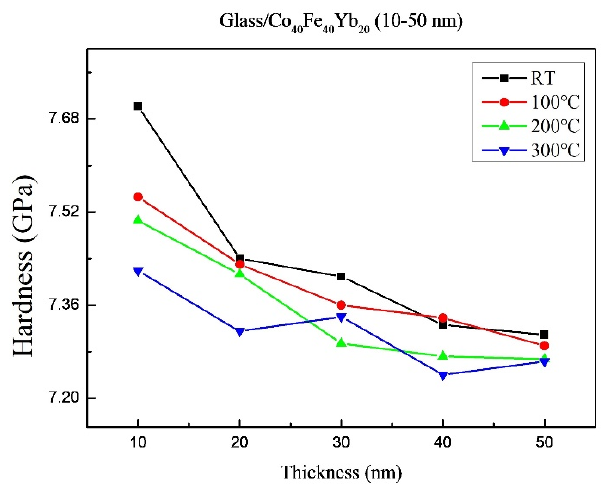
Figure 6. Average hardness of the Co 40 Fe 40 Yb 20 thin films.